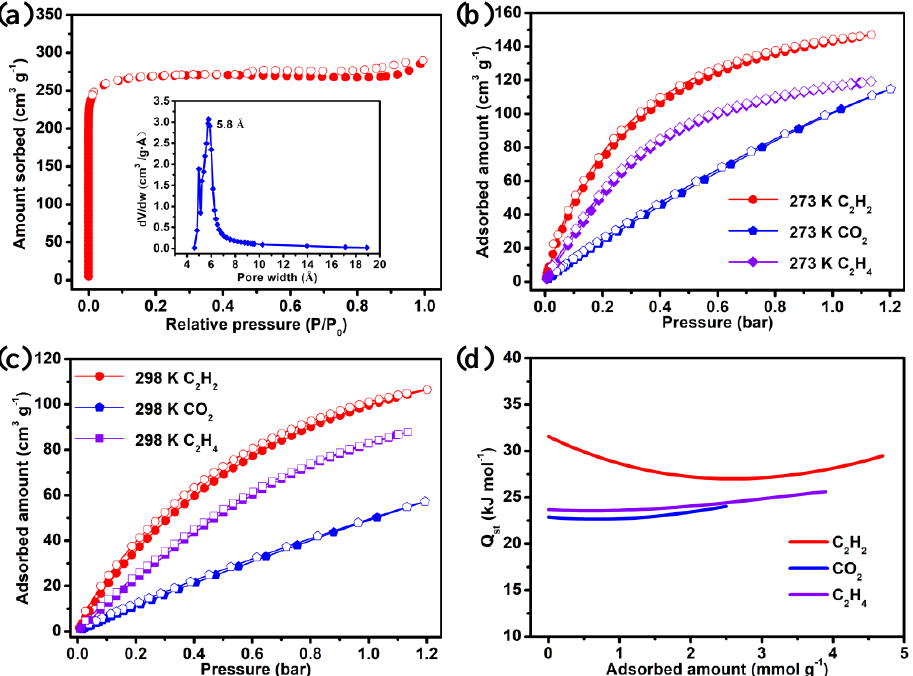
Figure 2. ( a ) N 2 sorption isotherm and pore size distribution of NUM-14a at 77 K. Single-component gas isotherms of C 2 H 2 , CO 2 , and C 2 H 4 for NUM-14a at ( b ) 273 K and ( c ) 298 K (filled and open sym- bols represent adsorption and desorption curves, respectively). ( d ) Isosteric enthalpy of adsorption of C 2 H 2 , CO 2 , and C 2 H in NUM-14a